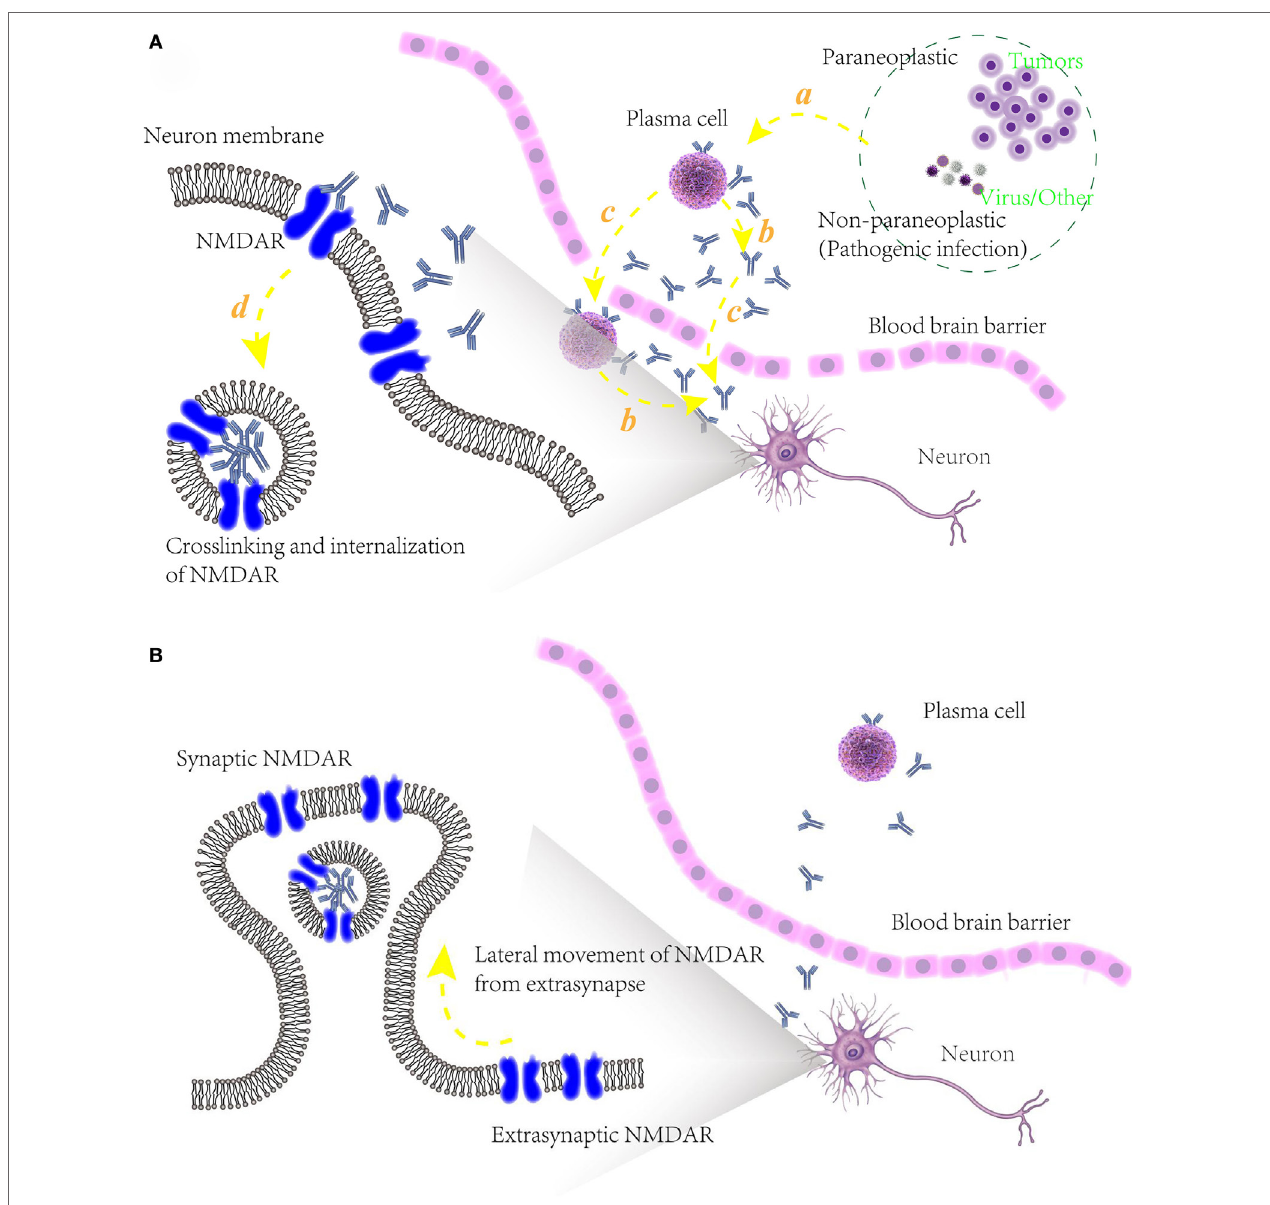
FiGURe 3 | (A) Schematic models of potential pathogenic mechanism of autoimmune epilepsy (AE) diseases associated with N -methyl- d -aspartate receptor (NMDAR) autoantibodies. (a) Initiation of B cells, triggered by paraneoplastic agents like tumors or non-paraplastic factors like virus or infection. (b) Secretion of specific antibodies to NMDAR. (c) Blood–brain barrier disruption, allowing the infiltration into cerebrospinal fluid of plasma cells, specific antibodies and maybe other relative immunological cells. (d) Attenuation of NMDAR function, caused by the binding of NMDAR with antibodies and internalization of presynaptic NMDAR; (B) underlying mechanism of recovery of some AE diseases associated with NMDAR autoantibodies. After an elimination of NMDAR densities in synapse, unblocked and functional NMDARs in extrasynapse move laterally into preexisting synapses in a compensatory way, maintaining the stability of neuronal network